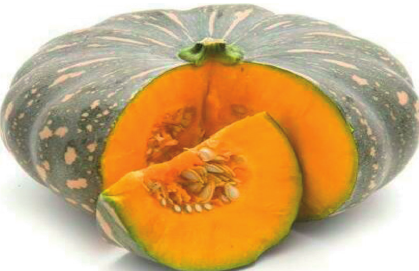
Figure 1: Pumpkin ( Cucurbita maxima ).